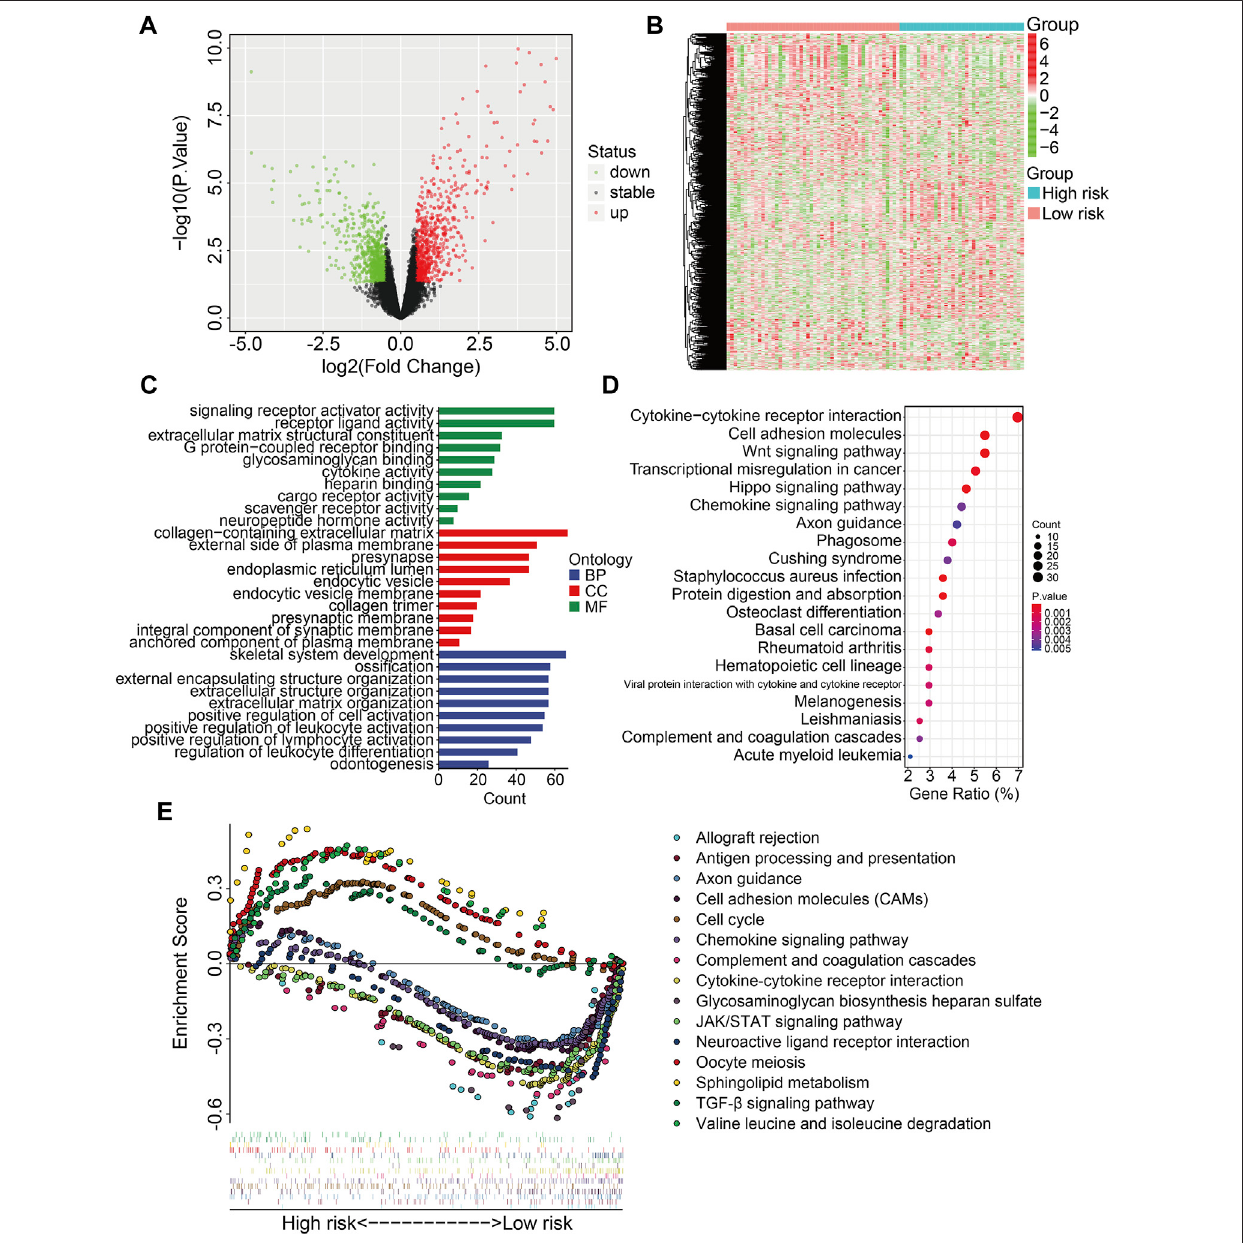
FIGURE 7 | Identi fi cation of risk-related differentially expressed genes and functional enrichment analysis. (A,B) The volcano plot and heatmap exhibited differentially expressed genes between high- and low-risk groups. (C) GO enrichment analysis. (D) KEGG pathway enrichment analysis. (E) GSEA analysis between high- and low-risk groups. Each kind of color represents an enriched